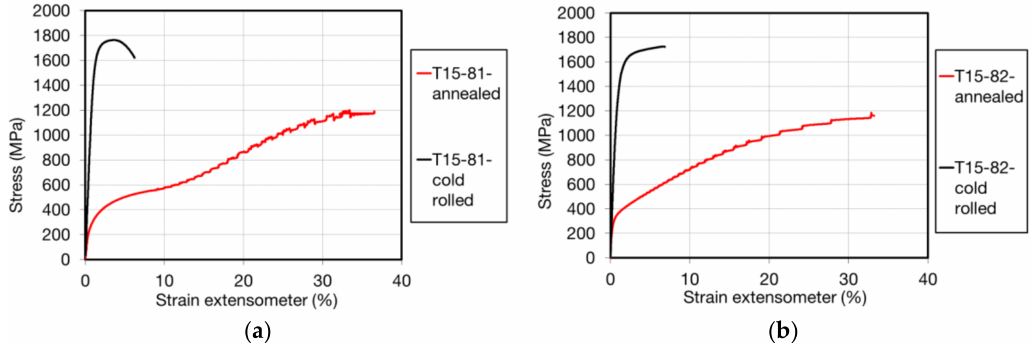
Figure 4. Engineering stress-strain curves of sheets in as cold rolled and annealed states: ( a ) T15-81; and, ( b )